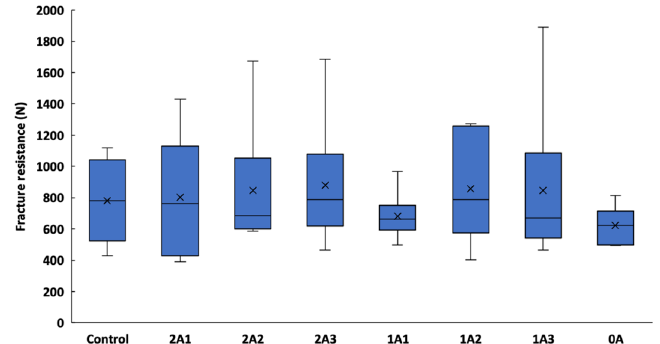
Figure 4. The fracture resistance of zirconia-reinforced lithium disilicate ceramic overlays restored on various cavity designs, compared with unaltered teeth (Control).